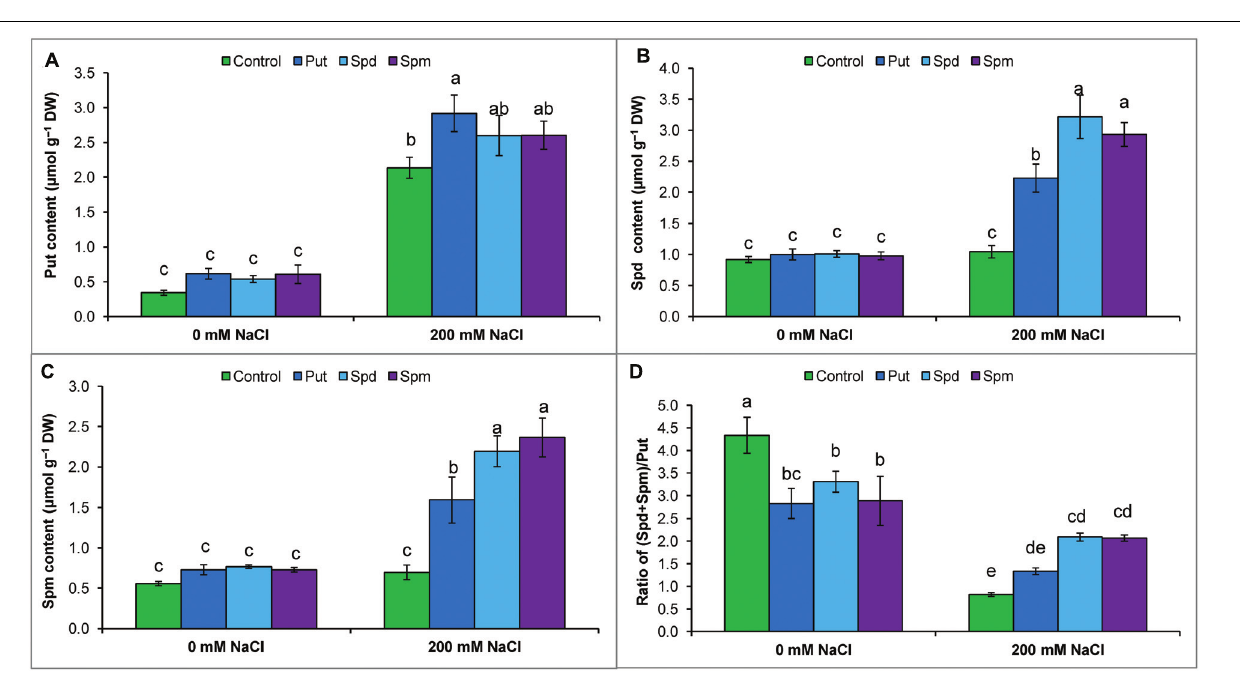
FIGURE 5 | Endogenous levels of free polyamines in salt (NaCl, 200 mM) affected mung bean seedlings induced by treatment with exogenous polyamines. Endogenous Put (A) , Spd (B) , and Spm (C) contents and the ratio of (Spd + Spm)/Put (D) . Here, Put, Spd, and Spm indicate exogenous putrescine (0.2 mM), spermidine (0.2 mM), and spermine (0.2 mM), respectively. Mean ( ± SD) was calculated from three replicates for each treatment. Bars with different letters are significantly different at P ≤ 0.05, applying Tukey’s HSD